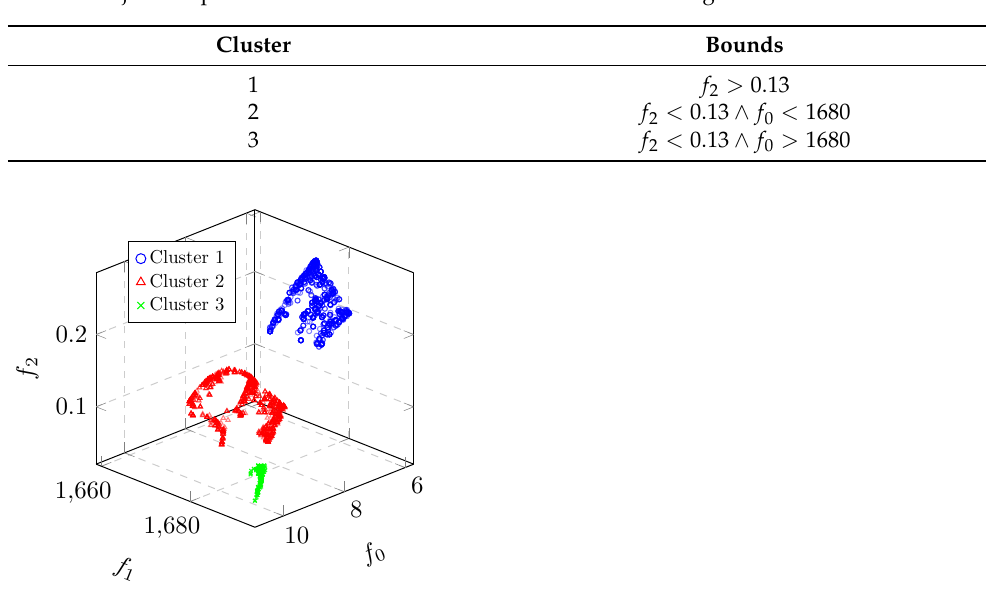
Figure 3. Non-dominated solutions from RE3-5-4 using bounded objective